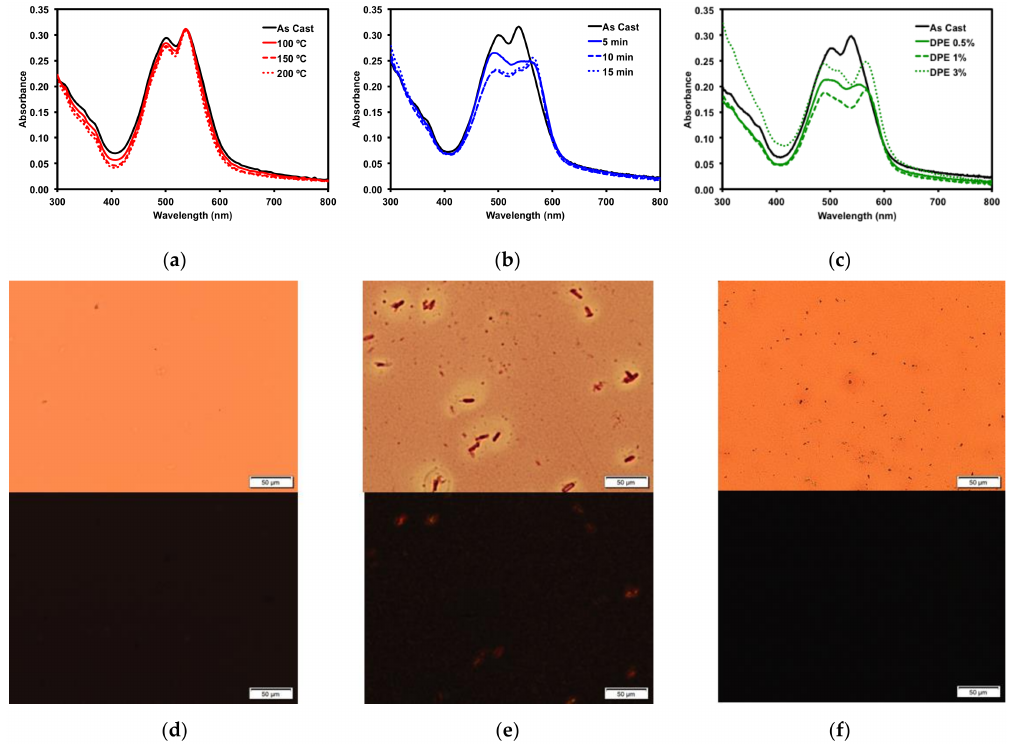
Figure 5. Optical absorption profiles of 1 with ( a ) thermal annealing; ( b ) o -DCB solvent vapour annealing; ( c ) DPE solvent additive. POM images of ( d ) 150 ◦ C TA film; ( e ) 15 min o -DCB SVA film; and ( f ) 3% v / v DPE additive film under normal (top) and cross-polarized light (bottom). Images were taken at 20 ×